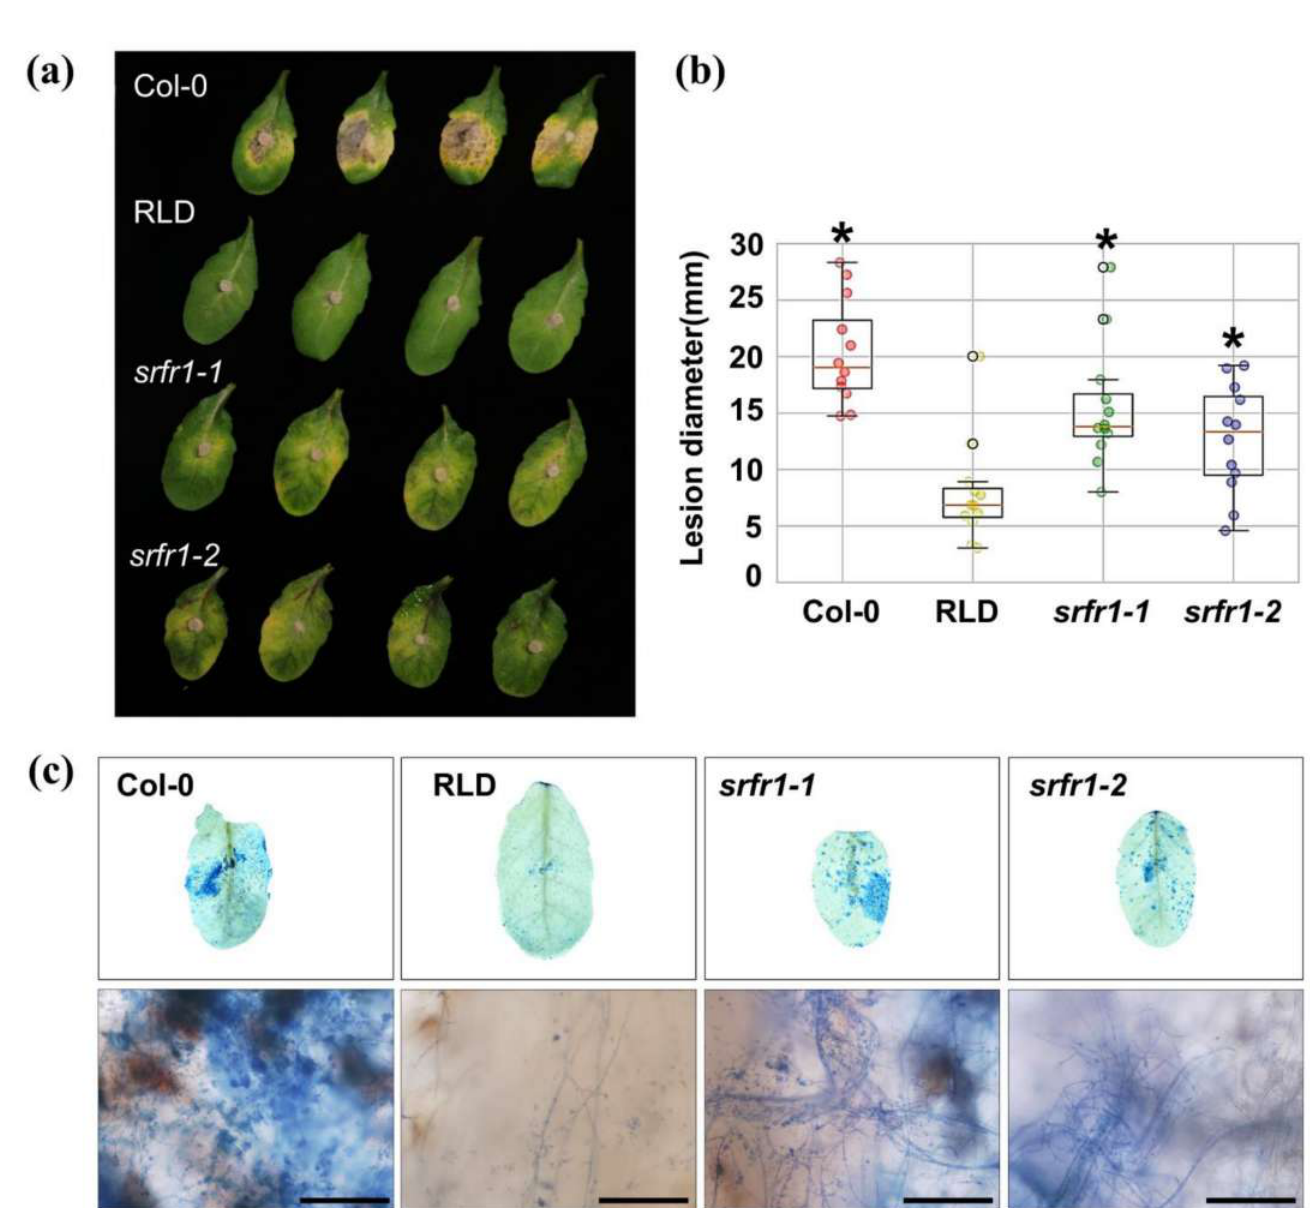
Figure 1. Response of Arabidopsis srfr1 mutants to the necrotrophic fungal pathogen, Fusarium oxysporum. ( a ) Infection with conidia and mycelial plugs on Arabidopsis RLD, srfr1-1, and srfr1-2 mutants. Detached leaves from 4-week-old plants were inoculated with 4 mm-diameter plugs of F. oxysproum . Photographs were taken at 14 DPI; ( b ) box plots of lesion size at 14 DPI in Col-0, RLD, srfr1-1 , and srfr1-2. The y-axis displays the measured diameter of disease lesion (mm, n = 12) in each plant. The box ranges were determined from the twenty-fifth to the seventy-fifth percentiles. A statistically significant difference was determined by the Student’s t -test (* p < 0.05); ( c ) Leaves were collected 14 DPI with F. oxysporum and stained with lacto-phenol trypan blue to visualize the extent of hyphal development. The upper panel represents destained leaves with 99% ethanol, and the lower panel indicates developed fungal hyphae in each plant. Scale bar: 200 µ m. This experiment was repeated once with similar